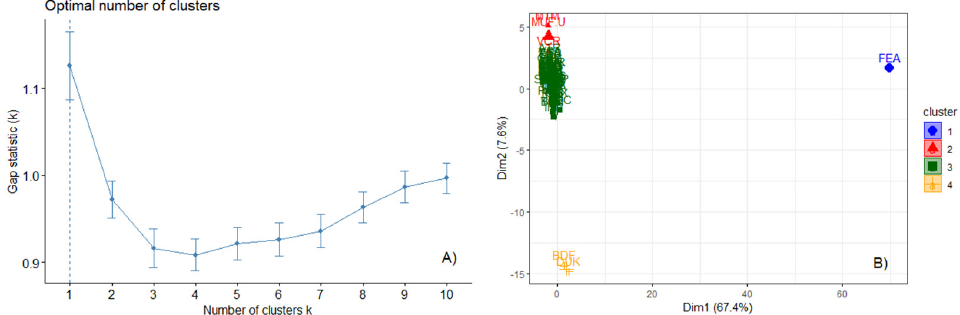
Figure 4. ( A ) Distinction and formation of groups by sites with similar characteristics (structure and diversity attributes) generated by k-means. ( B ) The percentage of variation explained by the eigenvalues of the formed groups was